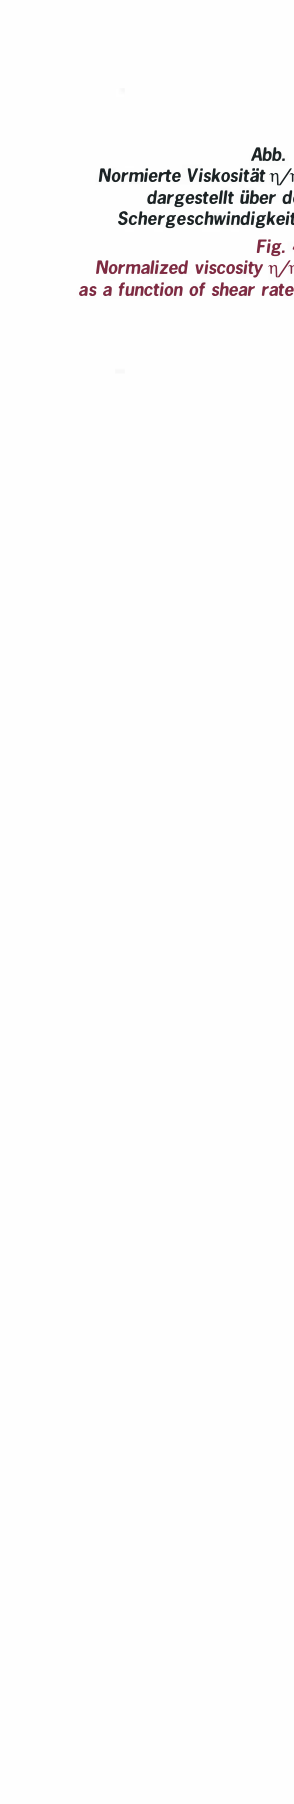
Die durchgezogene Linie entspricht dem Verlauf der Funktion (11) Fig. 5: Calculated extensional stress ov as a function of shear rate y. The line through the data corresponds to Equation (11)